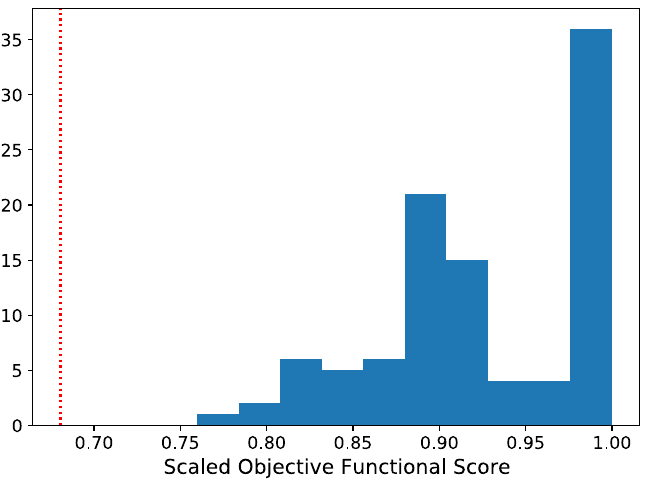
Figure 4. A histogram demonstrating all the scores obtained via the reinforcement learning process. The red dotted line indicates the expected score of a random